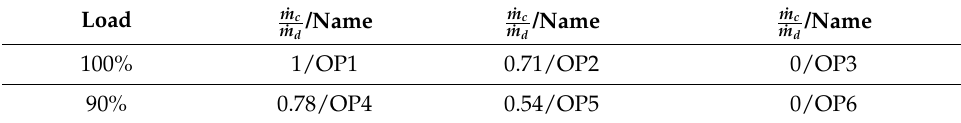
Table 1. Operating points and names according to Reference